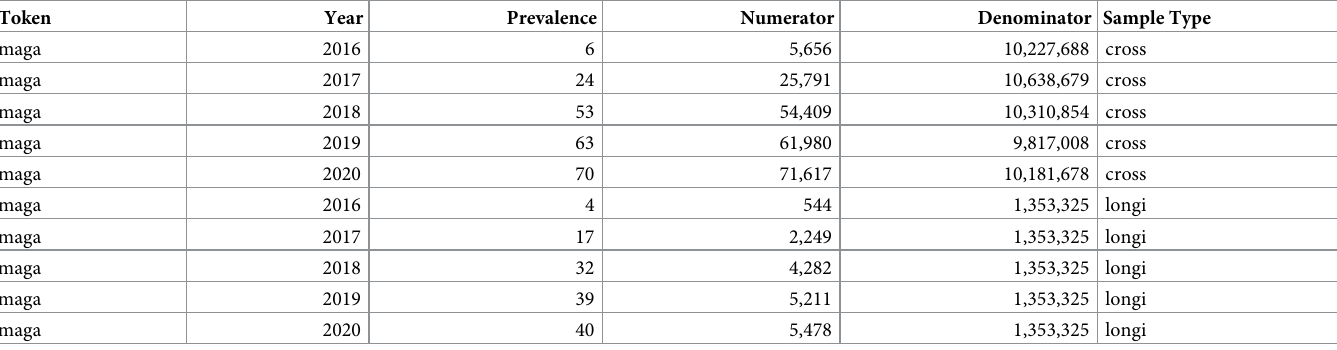
Table 2. Example rows of annual token